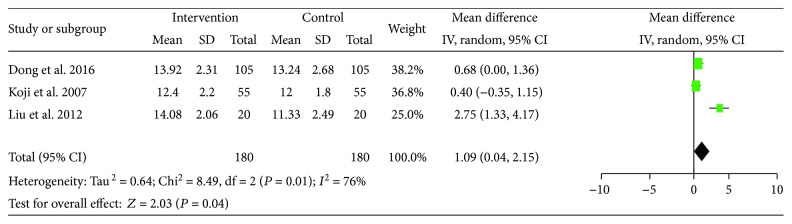
Forest plot for HGB.